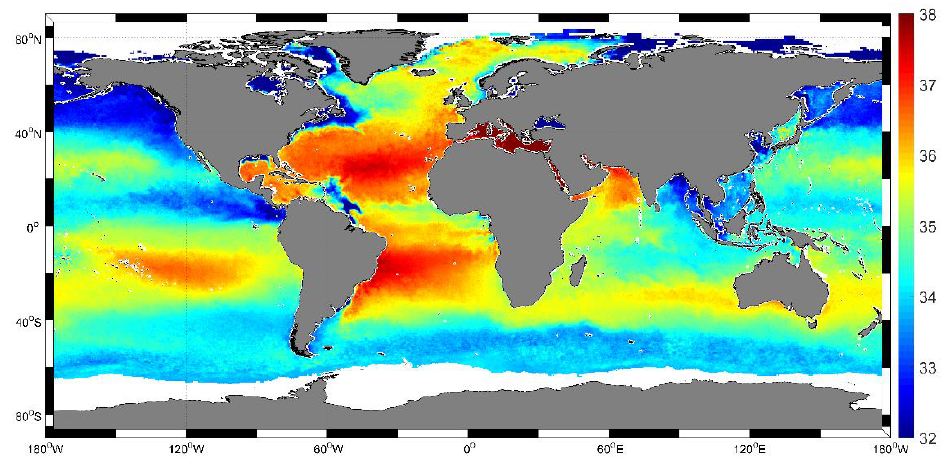
Figure 13. Marine salinity distribution